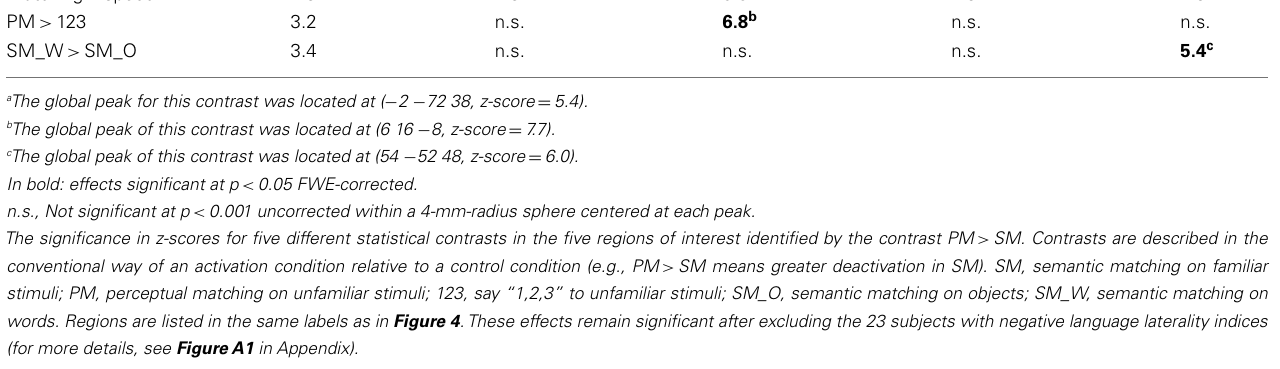
FIGURE 4 | Illustration of the mean effect size of five regions that showed greater deactivations during semantic matching than perceptual matching (at p < 0.05 FWE-corrected, seeTable 1). There were two significant clusters in PCC (labeled “1” and “4”), two clusters in ventral MPFC (labeled “2” and “3”), and one cluster in RIPL (labeled “5”) on the sagittal view. Because differences between non-objects and Greek symbols